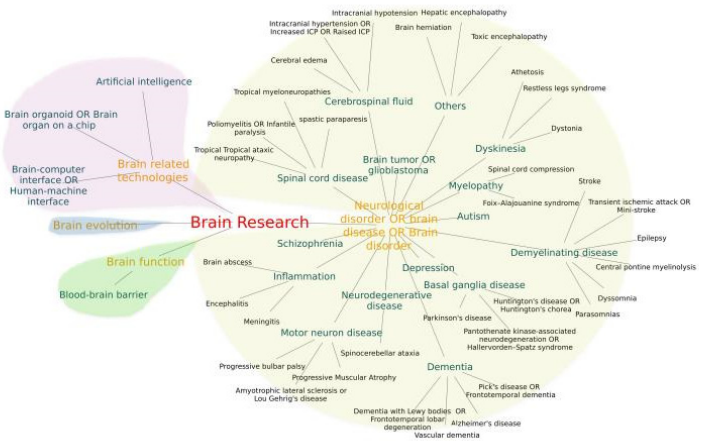
Figure 7. Systematic keywords network. Summarized keywords for systematic brain research. The different background colors of the branches of the networks presenting different fields of brain research.